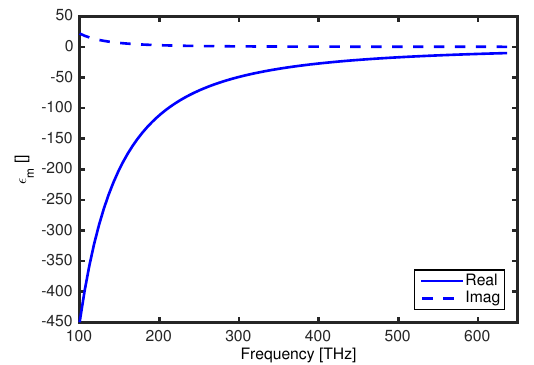
Figure 2: Real and imaginary parts of the relative permittivity for gold as functions of